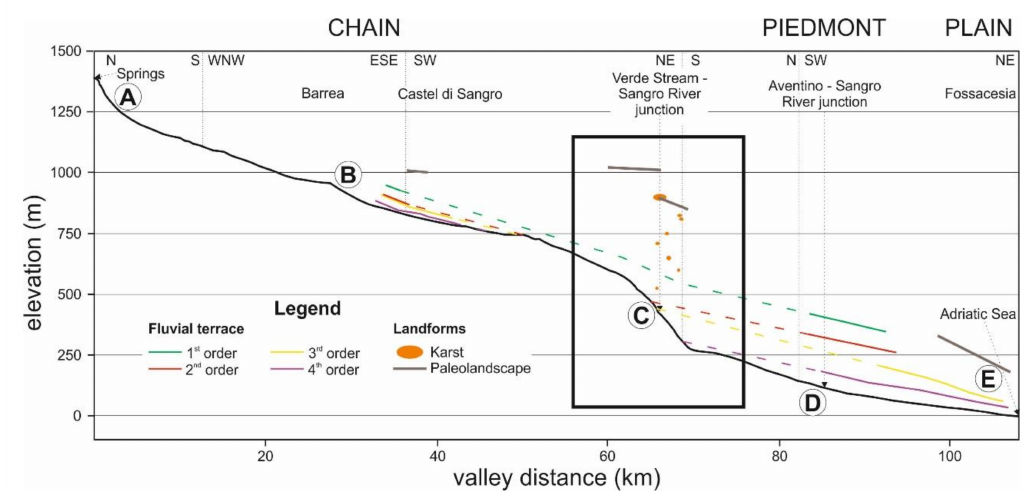
Figure 19. The Sangro River’s long profile with the plot of the karst landforms and the terraces gradient found in the Castel di Sangro plain [12,34] and those found in the plain near the Aventino–Sangro River junction [2]. The ages of these deposits are first order terrace, Middle Pleistocene; second order terrace, Late–Middle Pleistocene; third order terrace, Late Pleistocene; and fourth order terrace, Holocene [2]. Location of the study area (box); location in Figure 1, Figure 3, and Figure 14 (letters A, B, C, D,